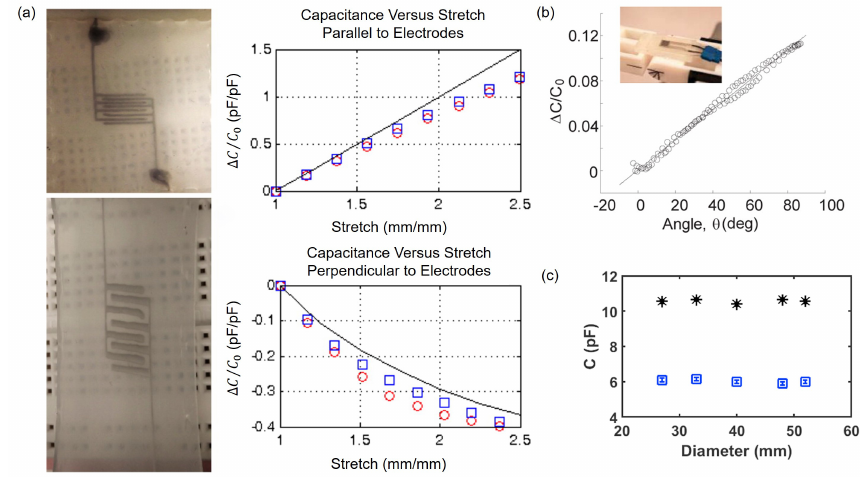
Figure 10. ( a ) Photographs of an interdigitated liquid metal capacitor stretched parallel (top left) and perpendicular (bottom left) to electrodes after uniaxial stretching of 250%. Normalized capacitance changes in the interdigitated capacitor as a function of uniaxial stretch parallel (top right) or perpendicular (bottom right) to electrodes. In each case, experiments (represented by red and blue markers) are conducted twice and black solid lines are theoretical predictions. Reprinted with permission from [48]. Copyright (2013) American Chemical Society. ( b ) Normalized capacitance changes of a parallel-plate liquid metal capacitor as a function of the bending angle. Reprinted with permission from [72]. Copyright (2015) American Chemical Society. ( c ) Capacitance as a function of the bending diameter. Two types of interdigitated liquid metal capacitors with their total width of 27 (black) or 57 mm (blue) are used. Reprinted from [73], Copyright (2015), with permission from